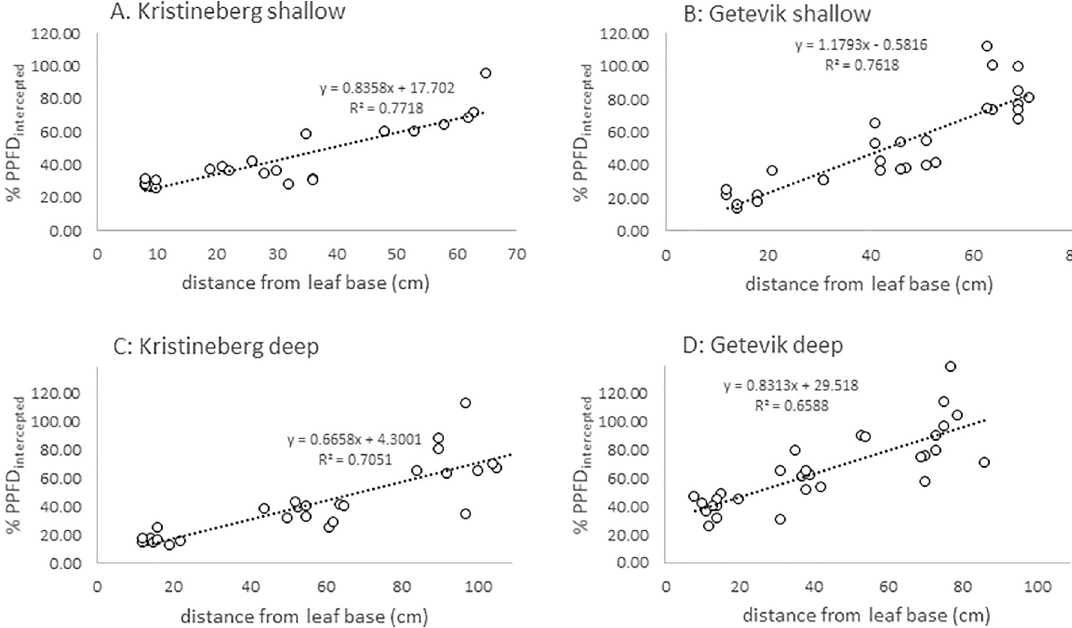
Fig 3. The amount of light intercepted by seagrass leaves as a percent of the light on top of the canopy (%PPFD intercepted ) at different positions along the leaves (measured as distance in cm from the sediment surface). A-D are the light interception (at each of the four sub-sites) as a function of the actual distance from the base of the